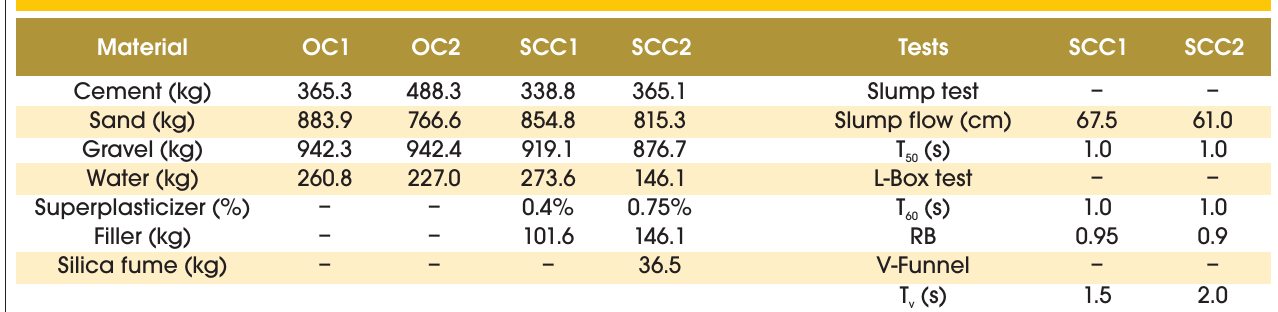
Table 1 – Materials content and fresh results for SCC